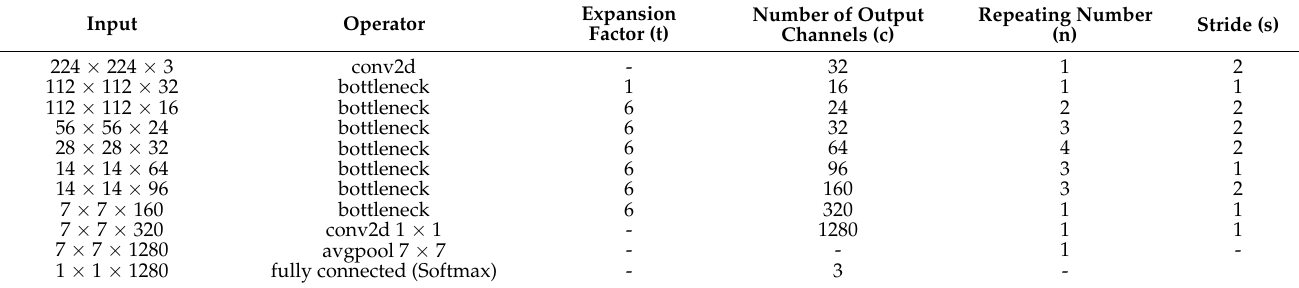
Table 4. MobileNetv2 architecture; each row represents a sequence of at least 1 identical layer, repeated n times. The number c of output channels is the same for each layer in the same sequence. The first layer of each sequence consists of a stride s while all the rest use stride 1. The expansion factor t is used for the input size.